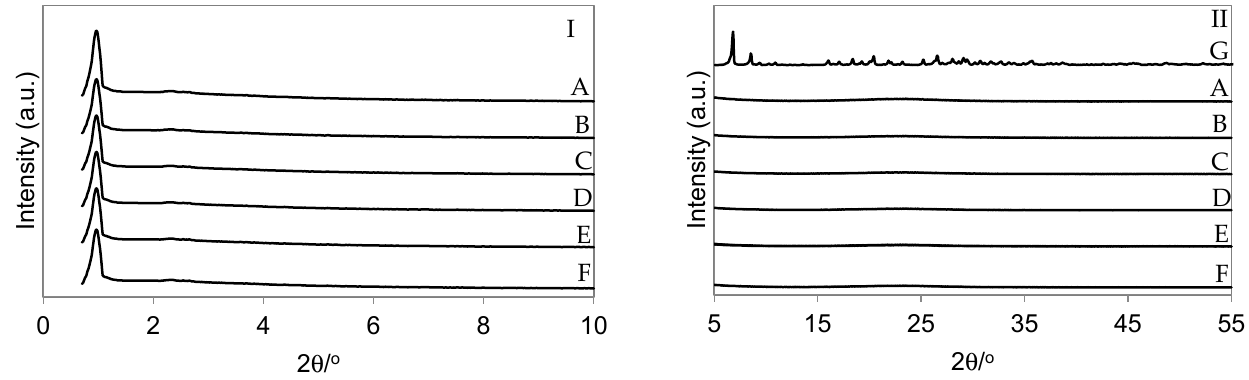
Figure 2. ATR-FTIR spectra of the catalysts: (line I) PW4-K-6; (line II) KIT-6; (line III) PW.